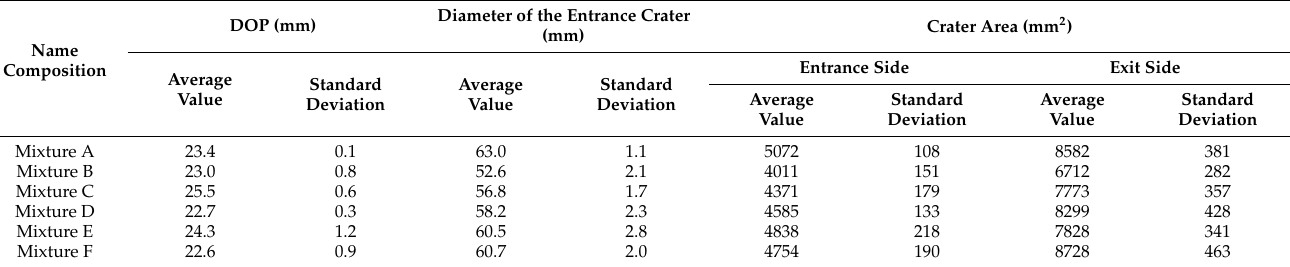
Figure 8. Tensile strength as a function of the age of the sample. Table 10. Damage sizes of UHPSFRC